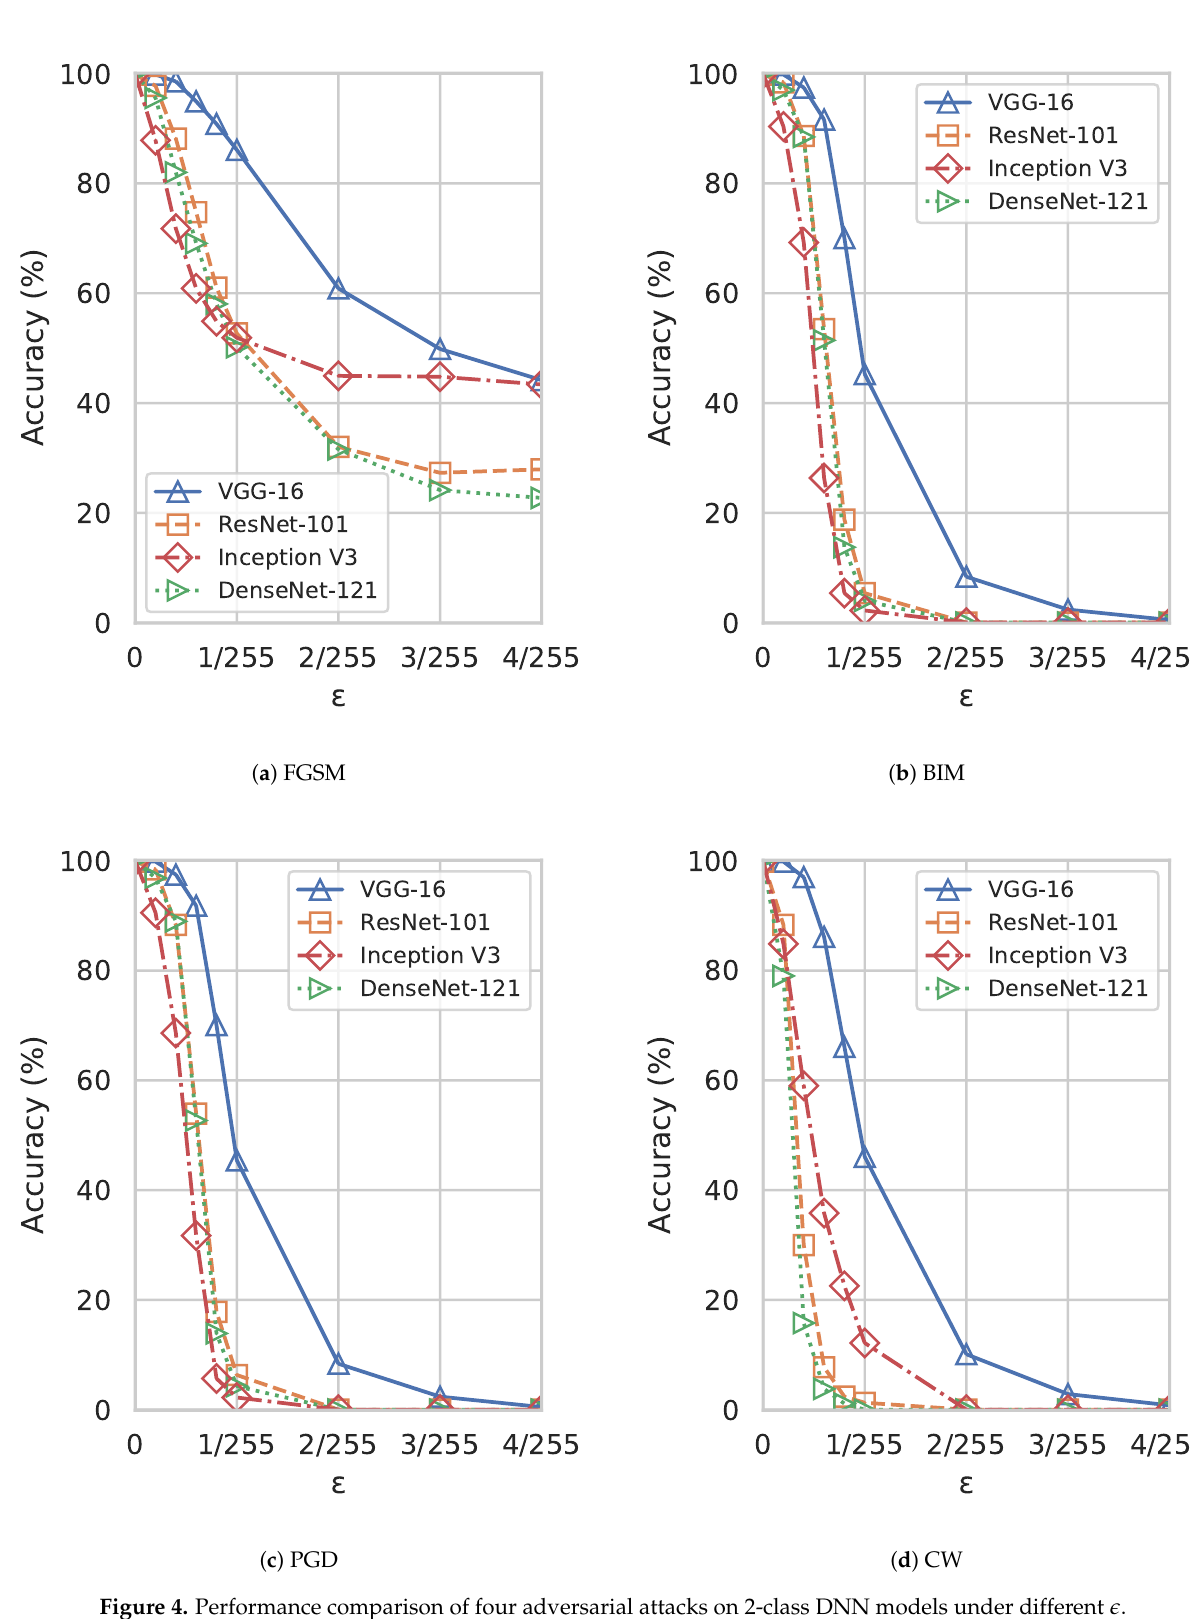
Figure 4. Performance comparison of four adversarial attacks on 2-class DNN models under different (cid:101)